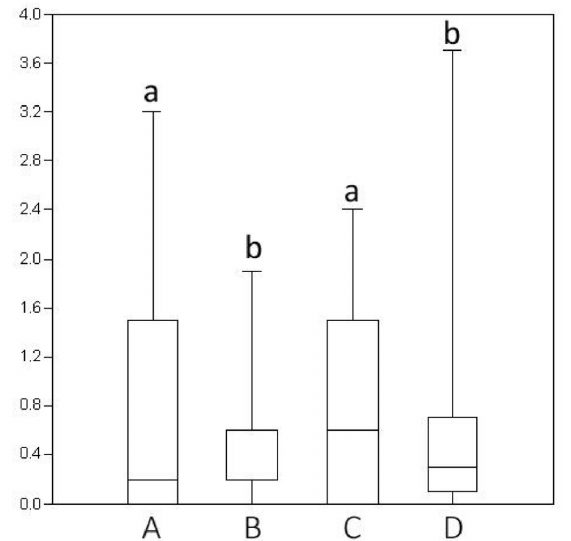
Figure 3. Comparison of the WAI along the studied routes to schools. a, b—homogeneous groups at p <